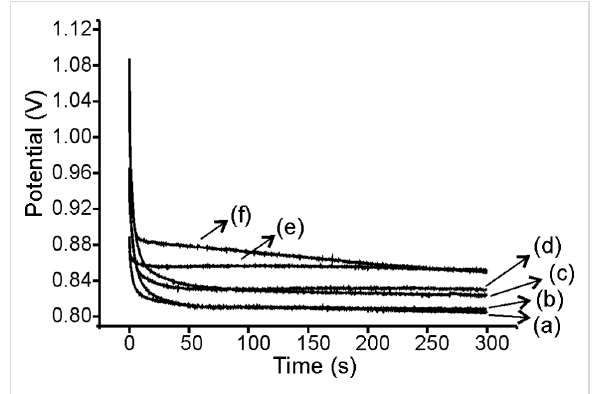
Figure 1: Chronopotentiometric curves obtained during the polymer- ization of (a) Ppy-CP Pt , (b) Ppy-CP SS (c) Ppy/AuNPs-T-CP SS (d) Ppy/AuNPs-T-CP Pt , (e) Ppy/AuNPs-C-CP Pt and (f) Ppy/AuNPs-C-CP SS .